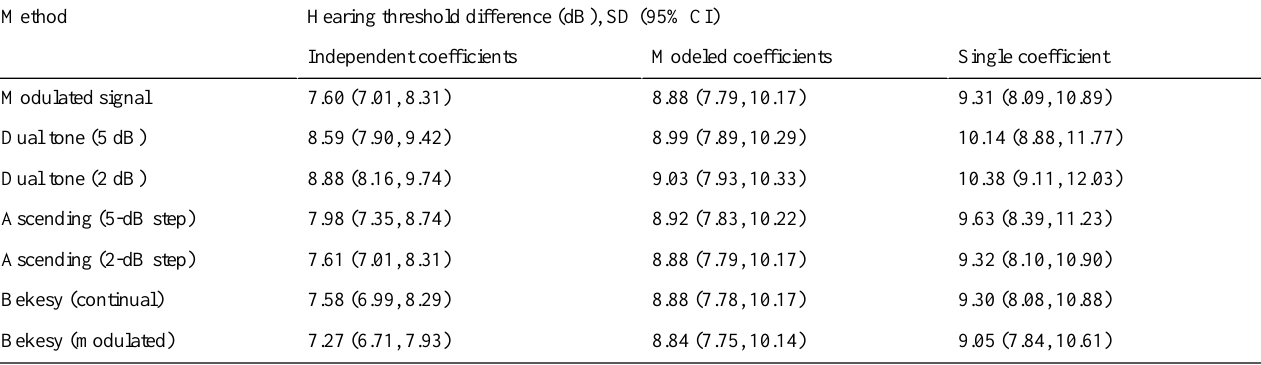
Table 5. The standard deviation of the difference in the hearing threshold determined by means of the ascending method between measurements on clinical audiometer and the biologically calibrated personal computer, together with corresponding confidence intervals at P =.05 estimated on the basis of measurements carried out by 25